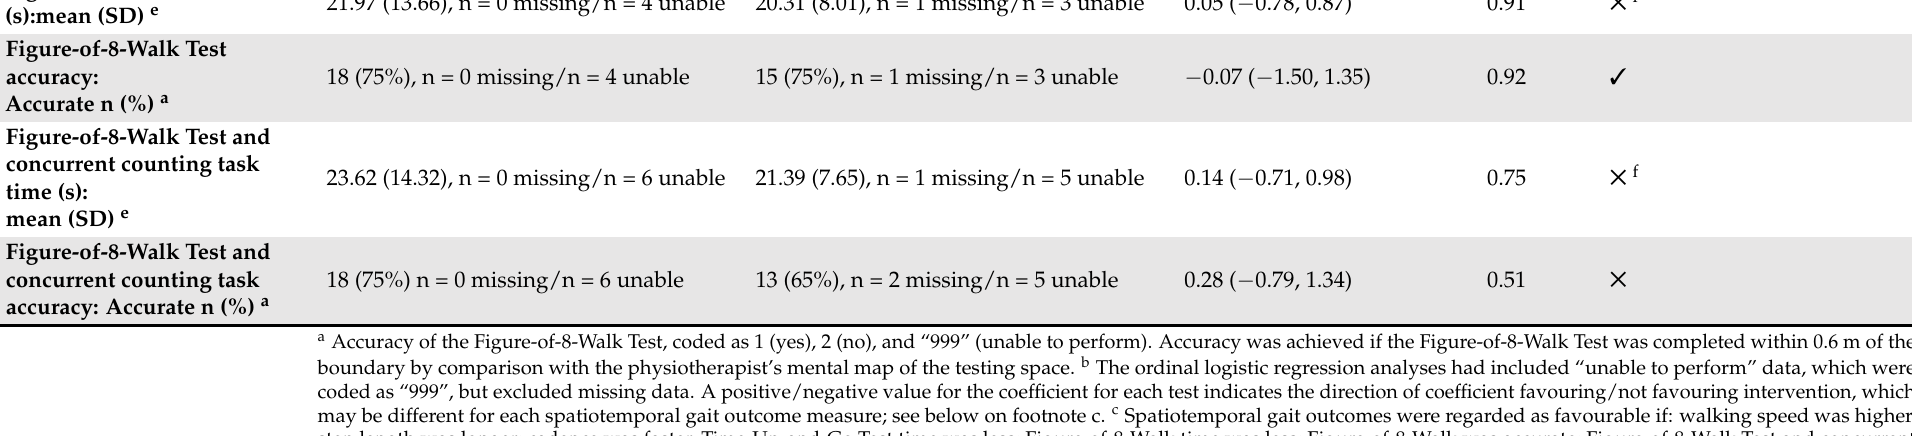
Figure-of-8-Walk Test time